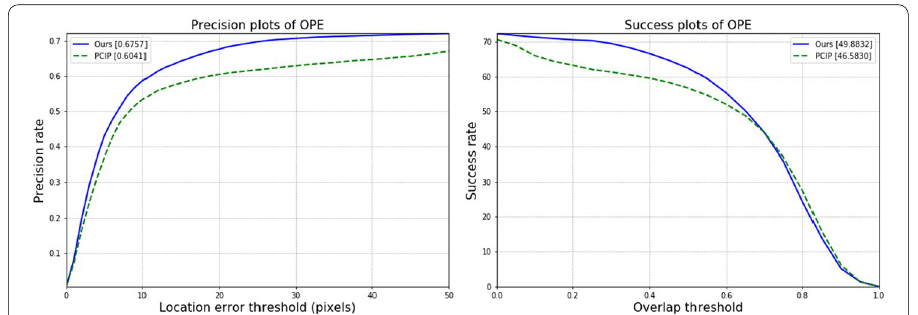
Fig.14 Success and precision plots of different feature network slimming methods on OTB2013 datasets